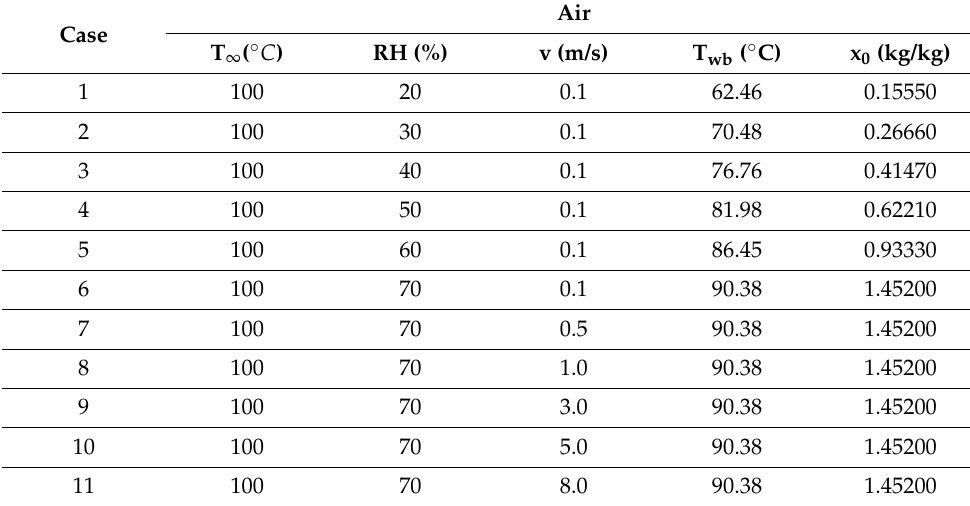
Table 6. Air and brick conditions used in drying simulations.